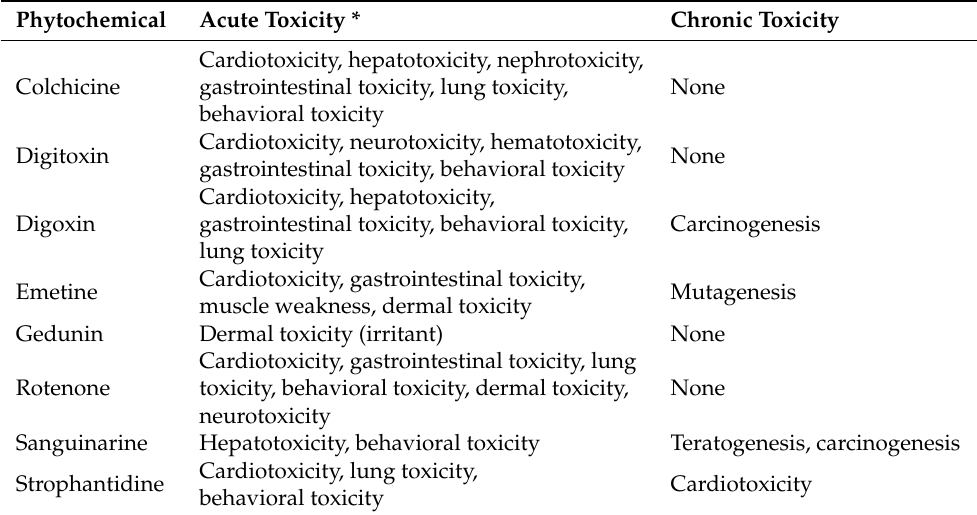
None None Carcinogenesis Mutagenesis None